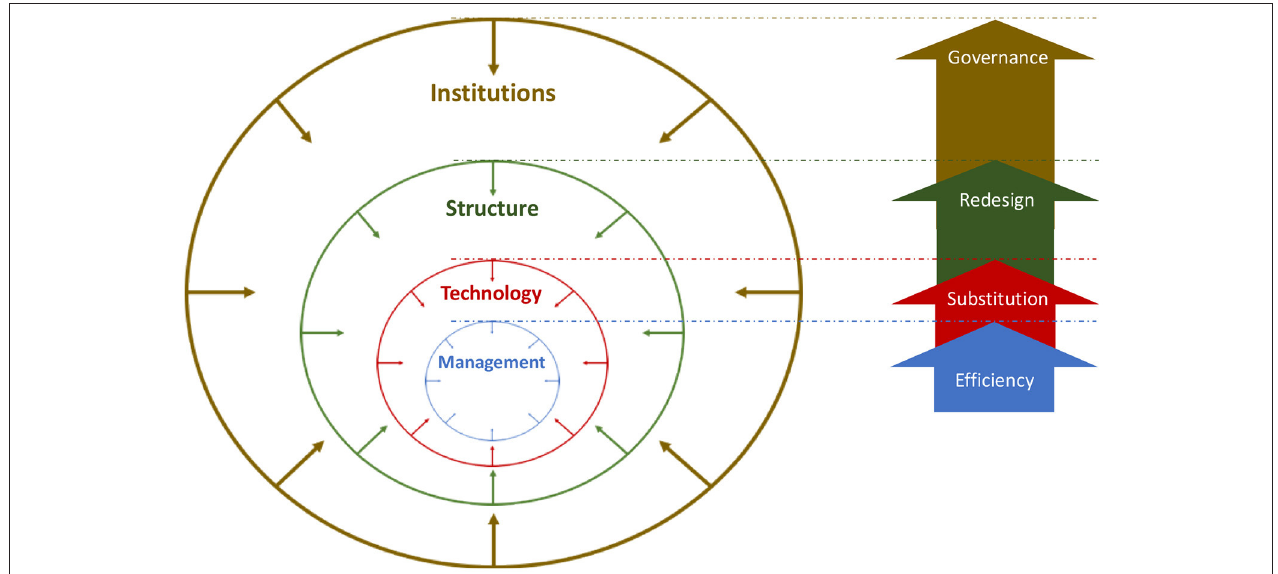
FIGURE 5 | Innovation domains for the ecological intensification of livestock systems in multi-functional landscapes represented as sets of nested constraints (left), and four phases in agroecological transitions necessary to face the constraints imposed by each domain (right). The size of the sets and the length of the block arrows indicate the relative strength of the constraints to agroecological transitions.